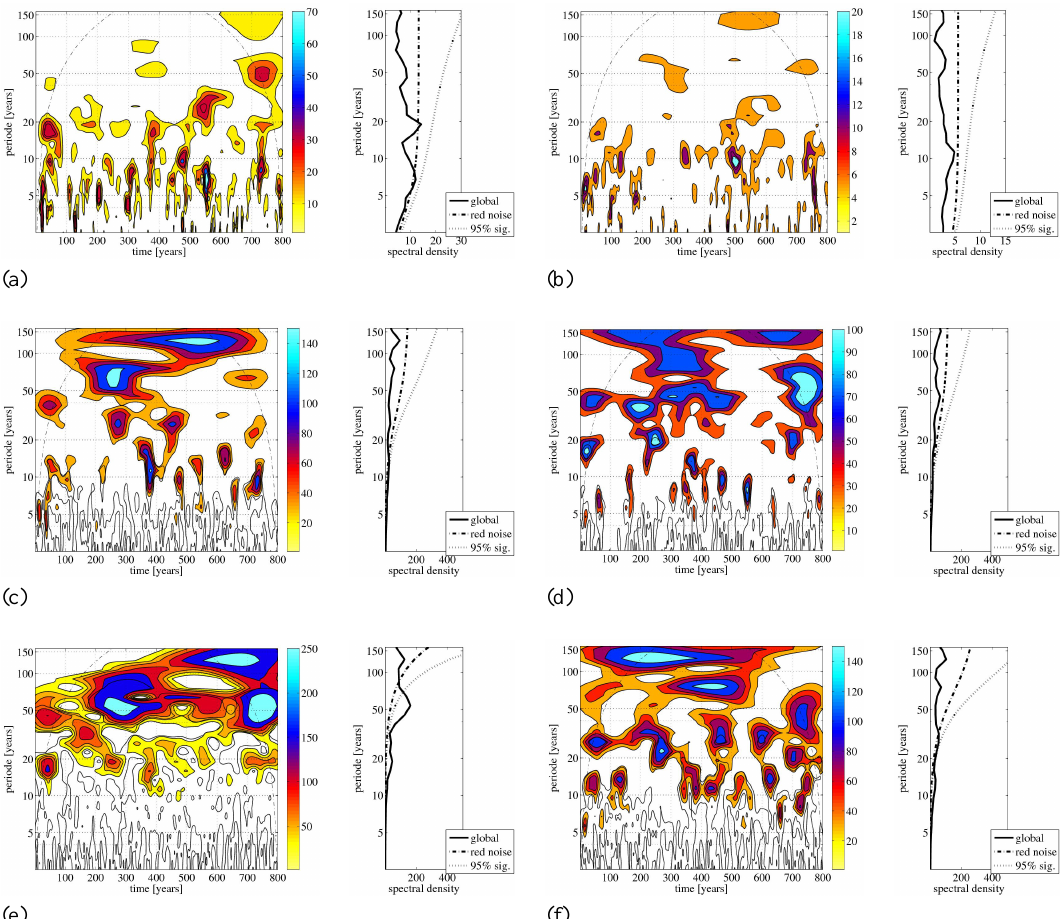
Fig. 12. (a) Wavelet spectrum for the monthly-averaged PC 1 of the geopotential height at 833hPa model level for the 1000yr run. (b) The same as in (a) , but for PC 2. (c) The same as in (a) , but for SST 0 over the Southern Hemisphere. (d) The same as in (b) , but for SST 0 over the Southern Hemisphere. (e) The same as in (a) , but for SST 0 over the ACC. (f) The same as in (b) , but for SST 0 over the